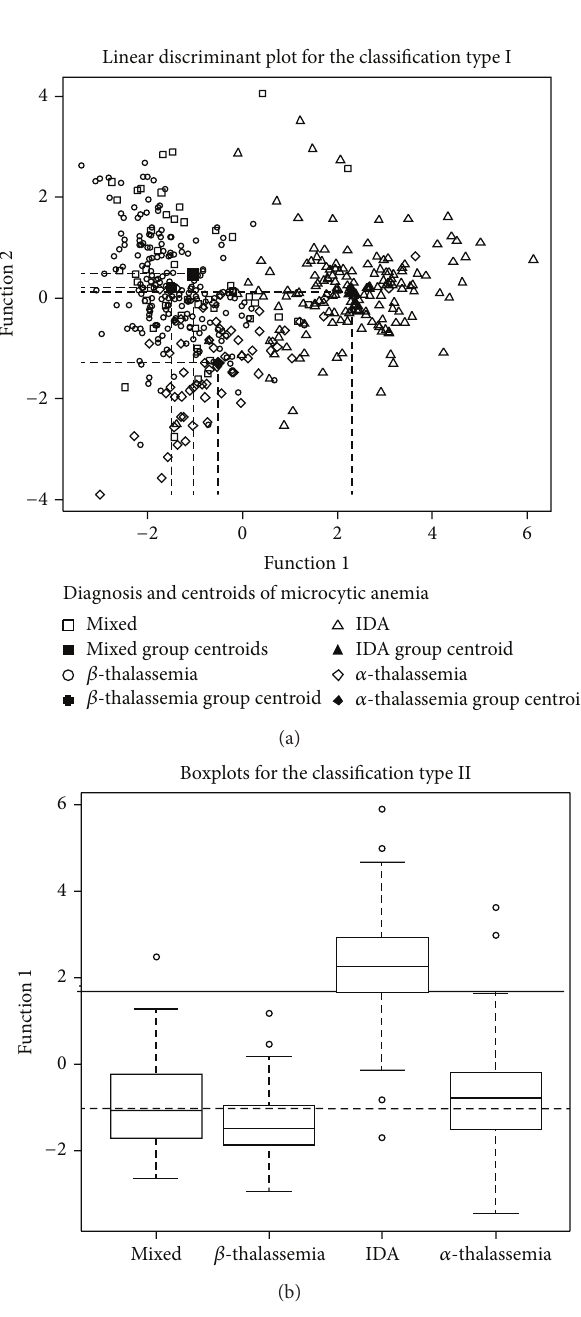
Figure 1: Linear discrimination plot for the studied classification type I (a) and boxplot for the classification type II in the training set (b). Black symbols in the linear discriminant plot indicate centroid groups. Dashed line in the boxplot reflects the cut-off value for the required discriminant